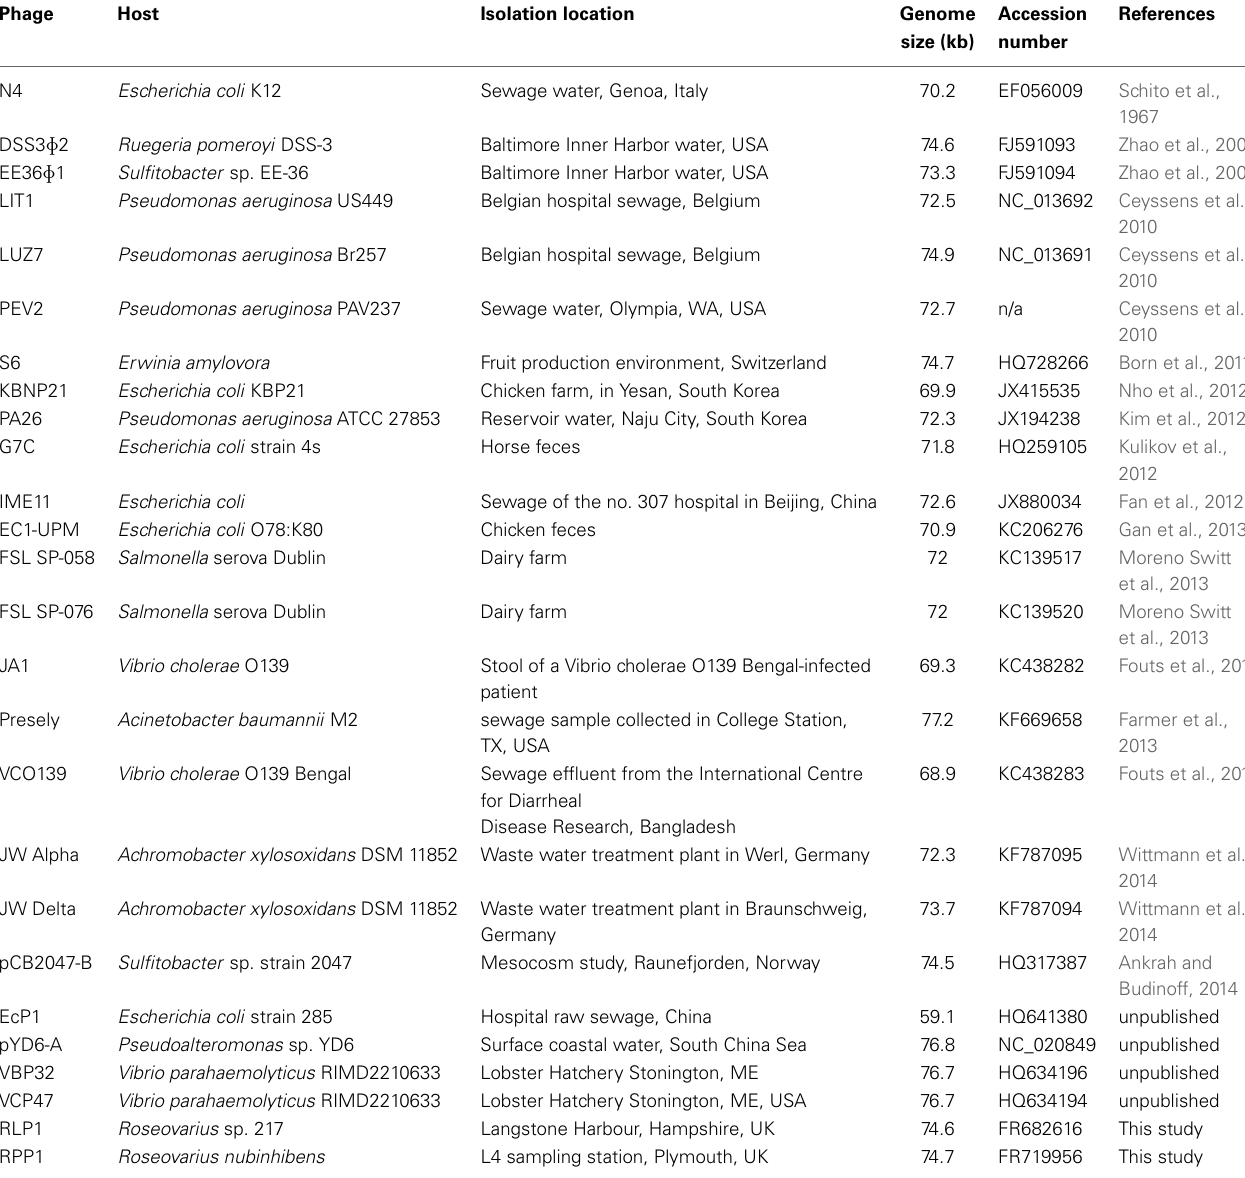
Table 1 | N4-like bacteriophages for which genome sequences are available.